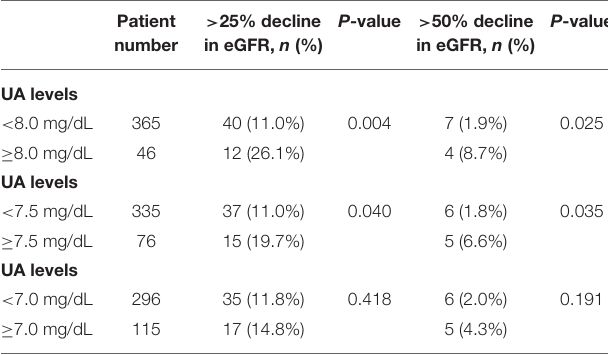
TABLE 5 | Uric acid and renal